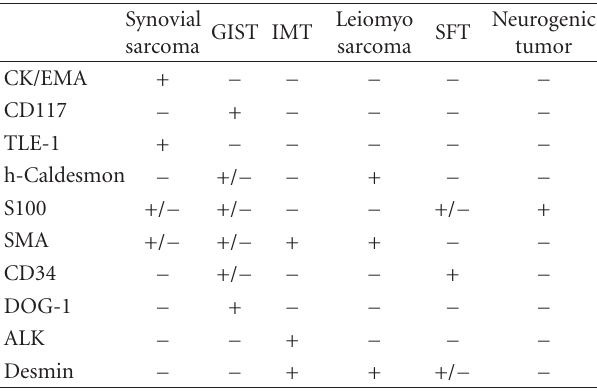
Table 1: Immunophenotype of the most common mesenchymal tumors in the gastrointestinal